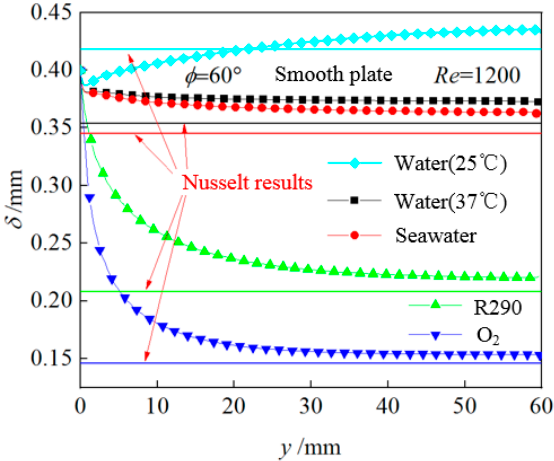
Figure 2. Local film thickness δ variation with y for different fluids.